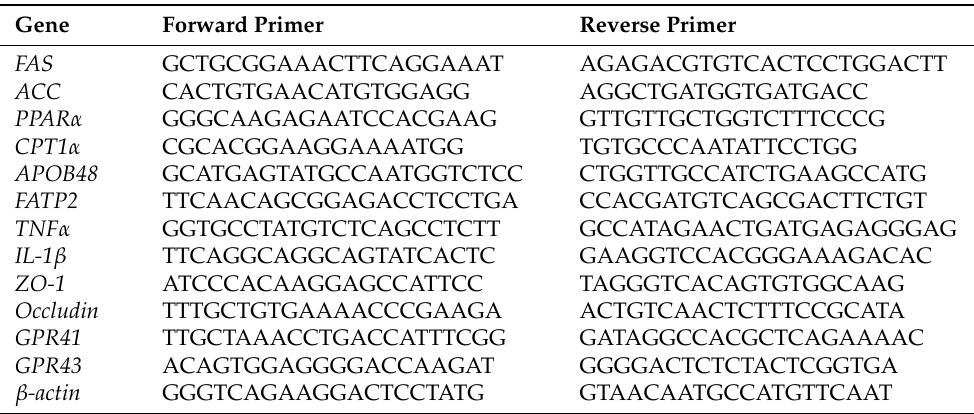
Table 1. Sequences of primers used for